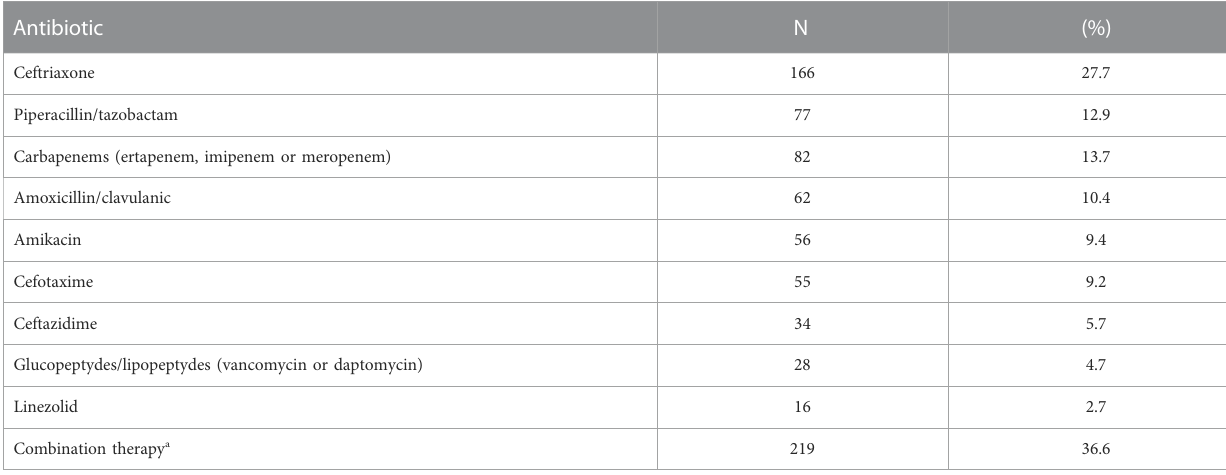
TABLE 3 Most frequent antibiotics used for empirical therapy.